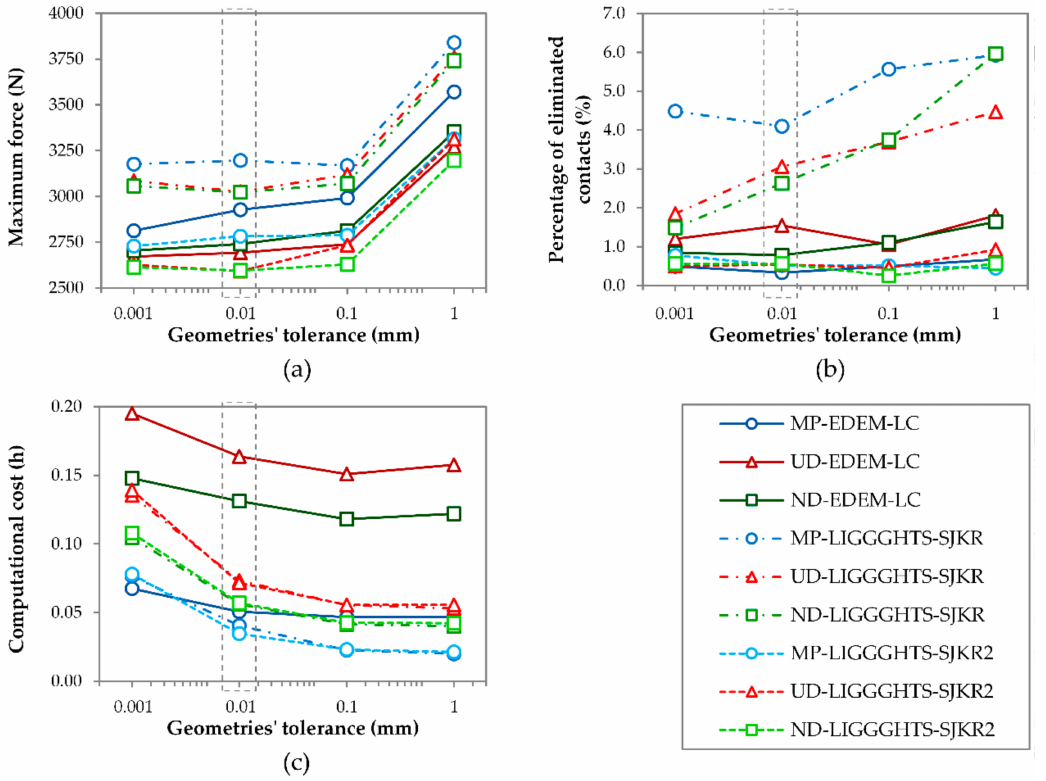
Figure 6. Effect of the conversion tolerance on ( a ) the maximum force applied by the punch, ( b ) the percentage of eliminated contacts after the removal of the matrix, and ( c ) the total computational